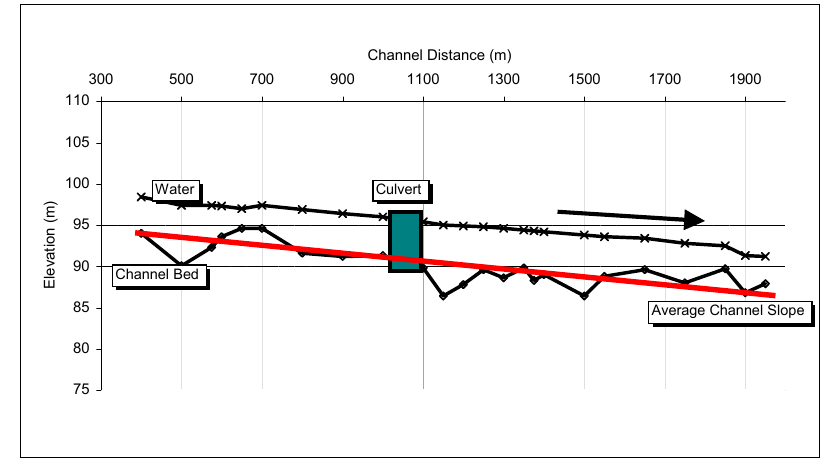
Figure 4. Example longitudinal profile with no channel bed off-set.